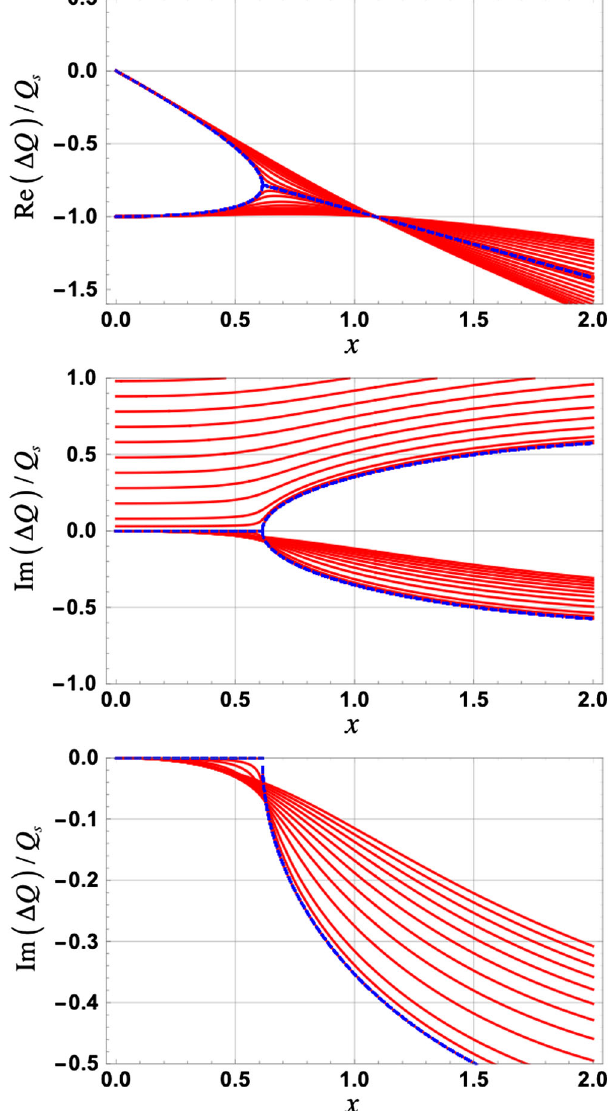
FIG. 6. Solutions of the diagonalisation of the 2 by 2 matrix of Eq. (2) vs x a normalized parameter proportional to the bunch intensity [4]: without (dotted blue line) and with (red line) the resistive TD for Δ Q TD =Q s ¼ 0; 0 . 03 j ; 0 . 08 j ; 0 . 18 j ; 0 . 28 j ; 0 . 38 j ; 0 . 48 j ; 0 . 58 j ; 0 . 68 j ; 0 . 78 j ; 0 . 88 j ; 0 . 98 j . The first two pic- tures describe the real and imaginary parts of the complex tune shift whereas the third one is a zoom of the imaginary part in the unstable